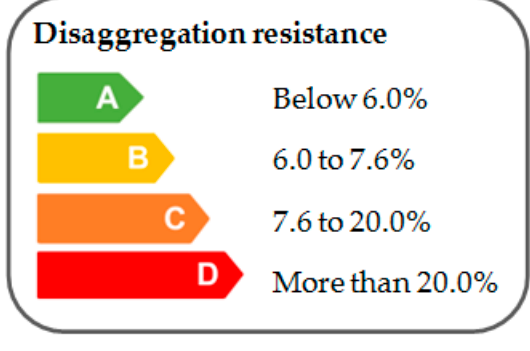
Figure 14. Disaggregation resistance labels based on the type of mixture.